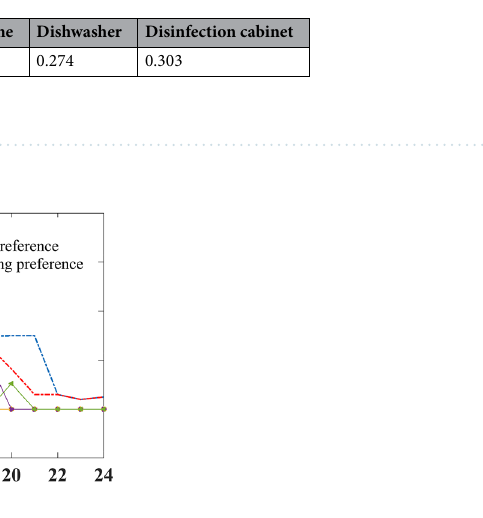
Figure 9. Power consumption plan after changing preference coefficient in